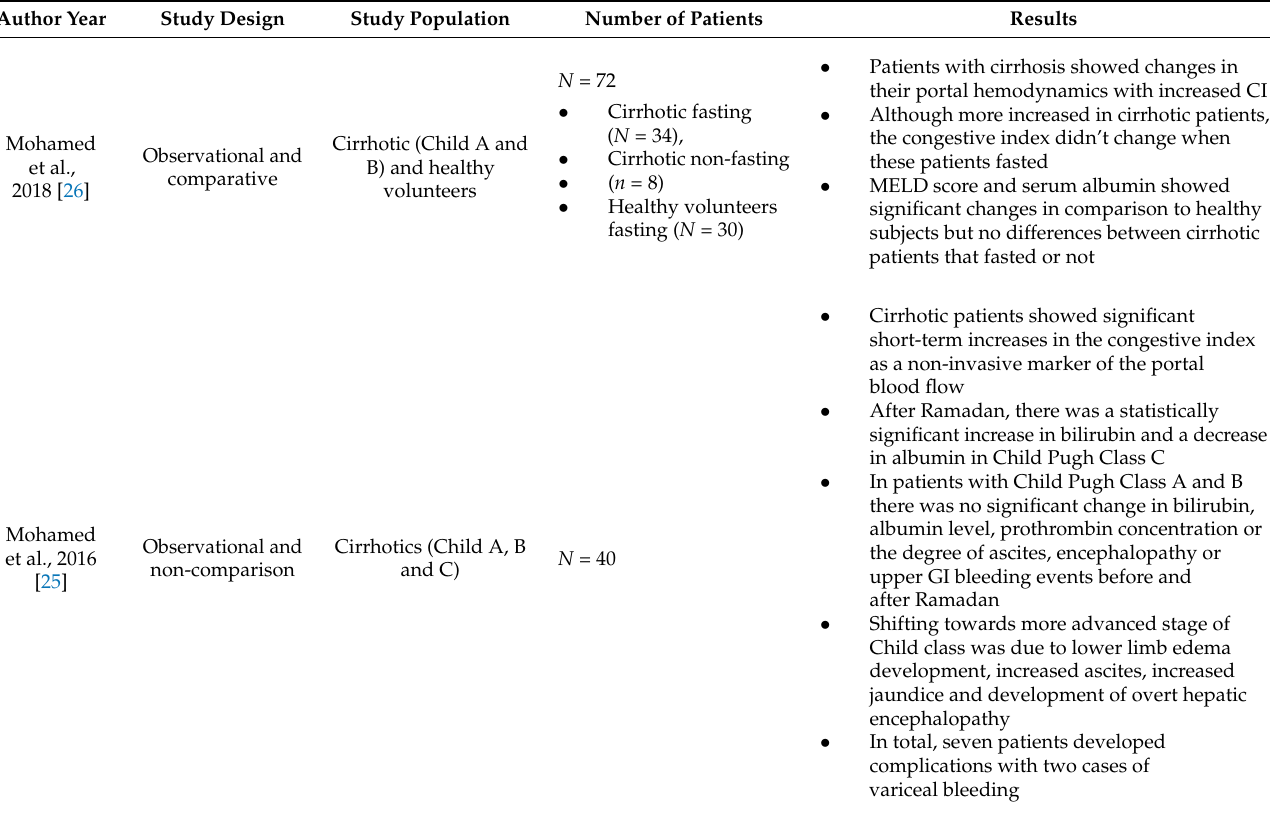
Table 2. The effects of Ramadan fasting in cirrhotic